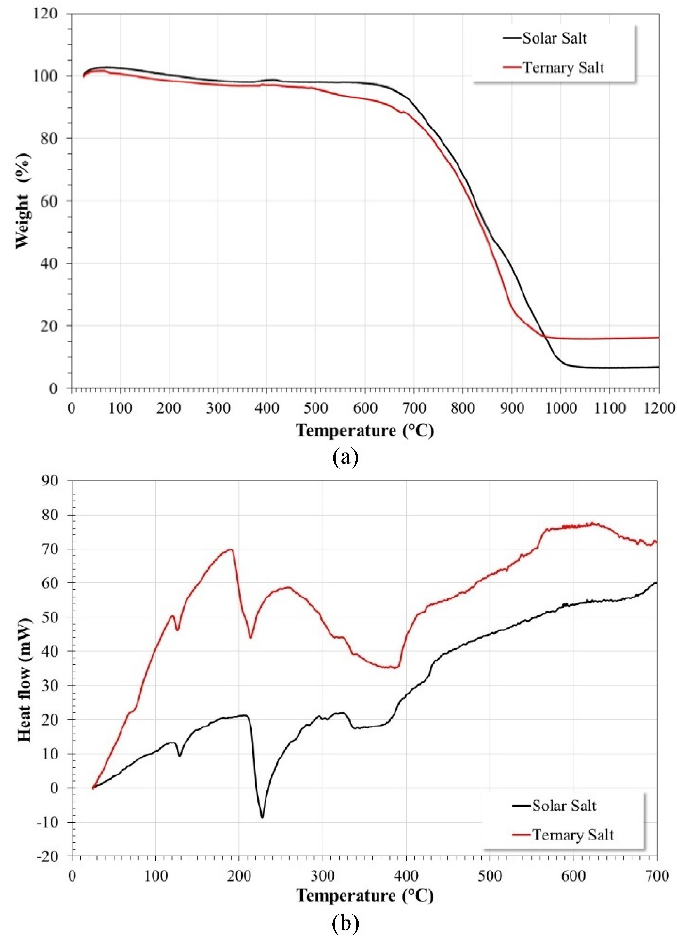
Figure 12. TGA-DSC Analysis of Solar Salt and ternary salt. ( a ) TGA curves, ( b ) DSC curves